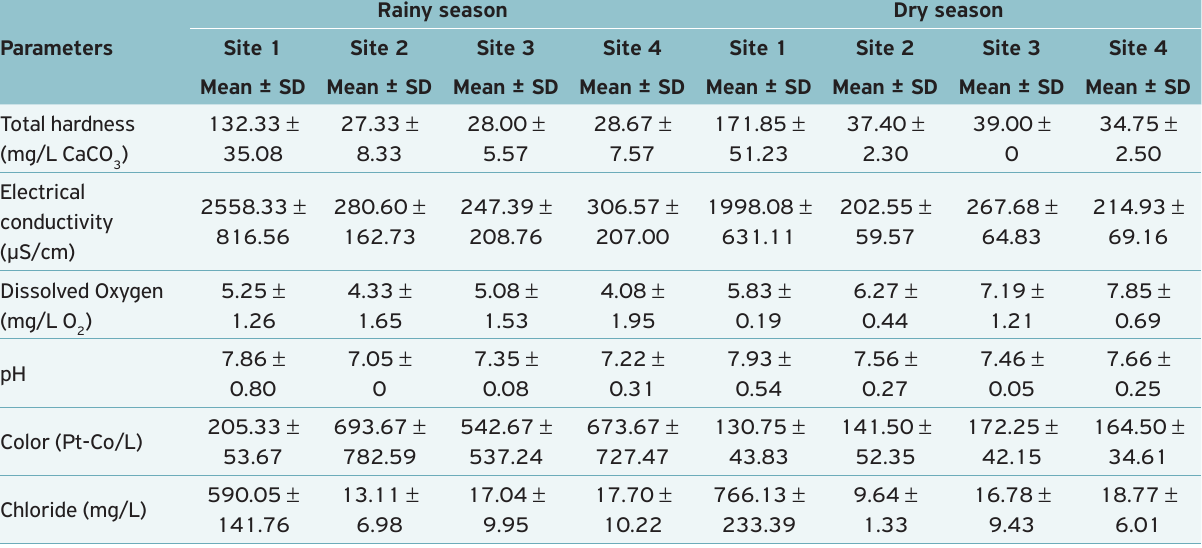
Table 2. Water quality parameters at different sites of the Atibaia River.